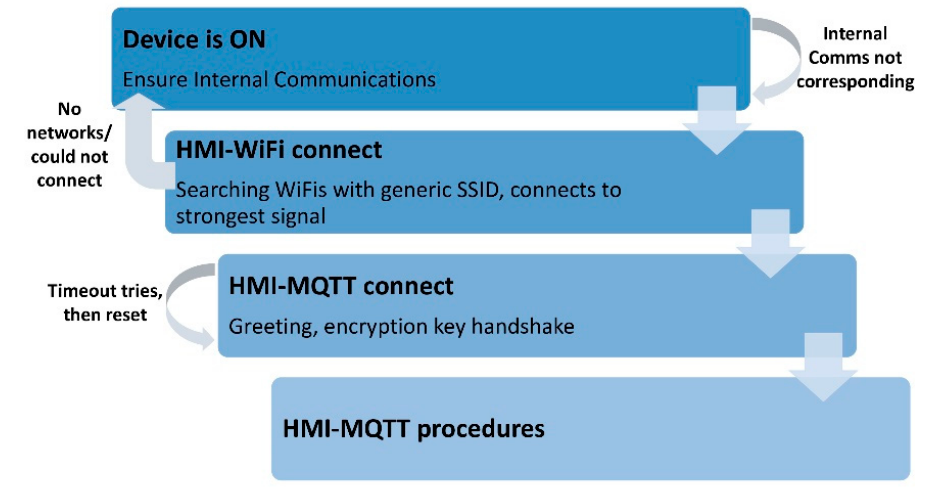
Figure 7. ULD connectivity block diagram.